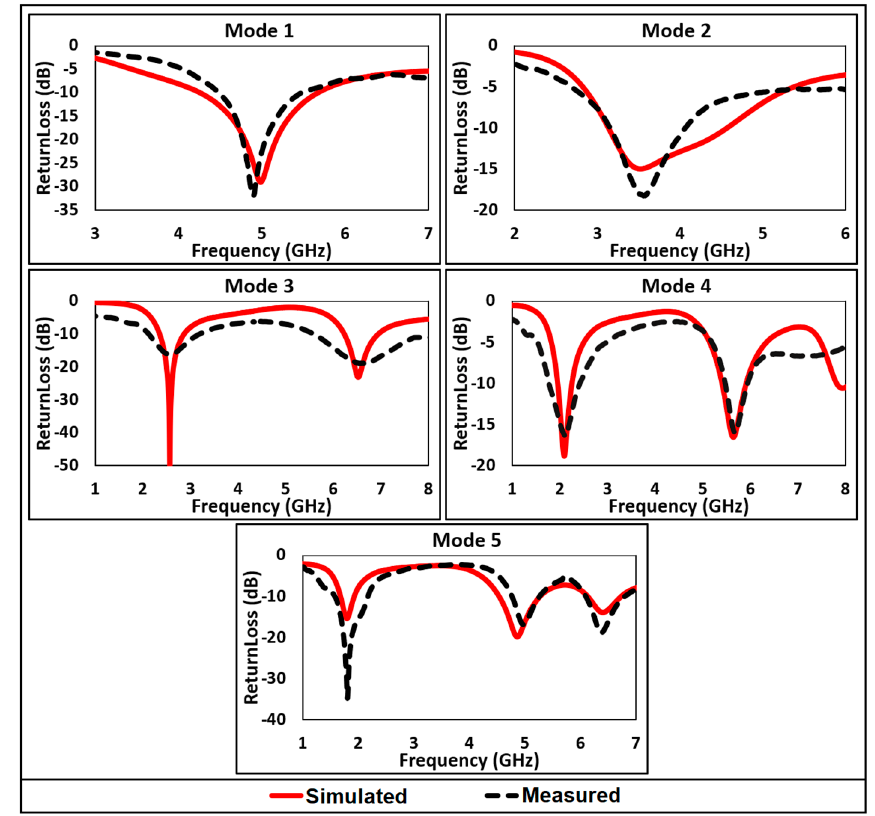
Figure 6. Comparison of simulated and measured return loss.